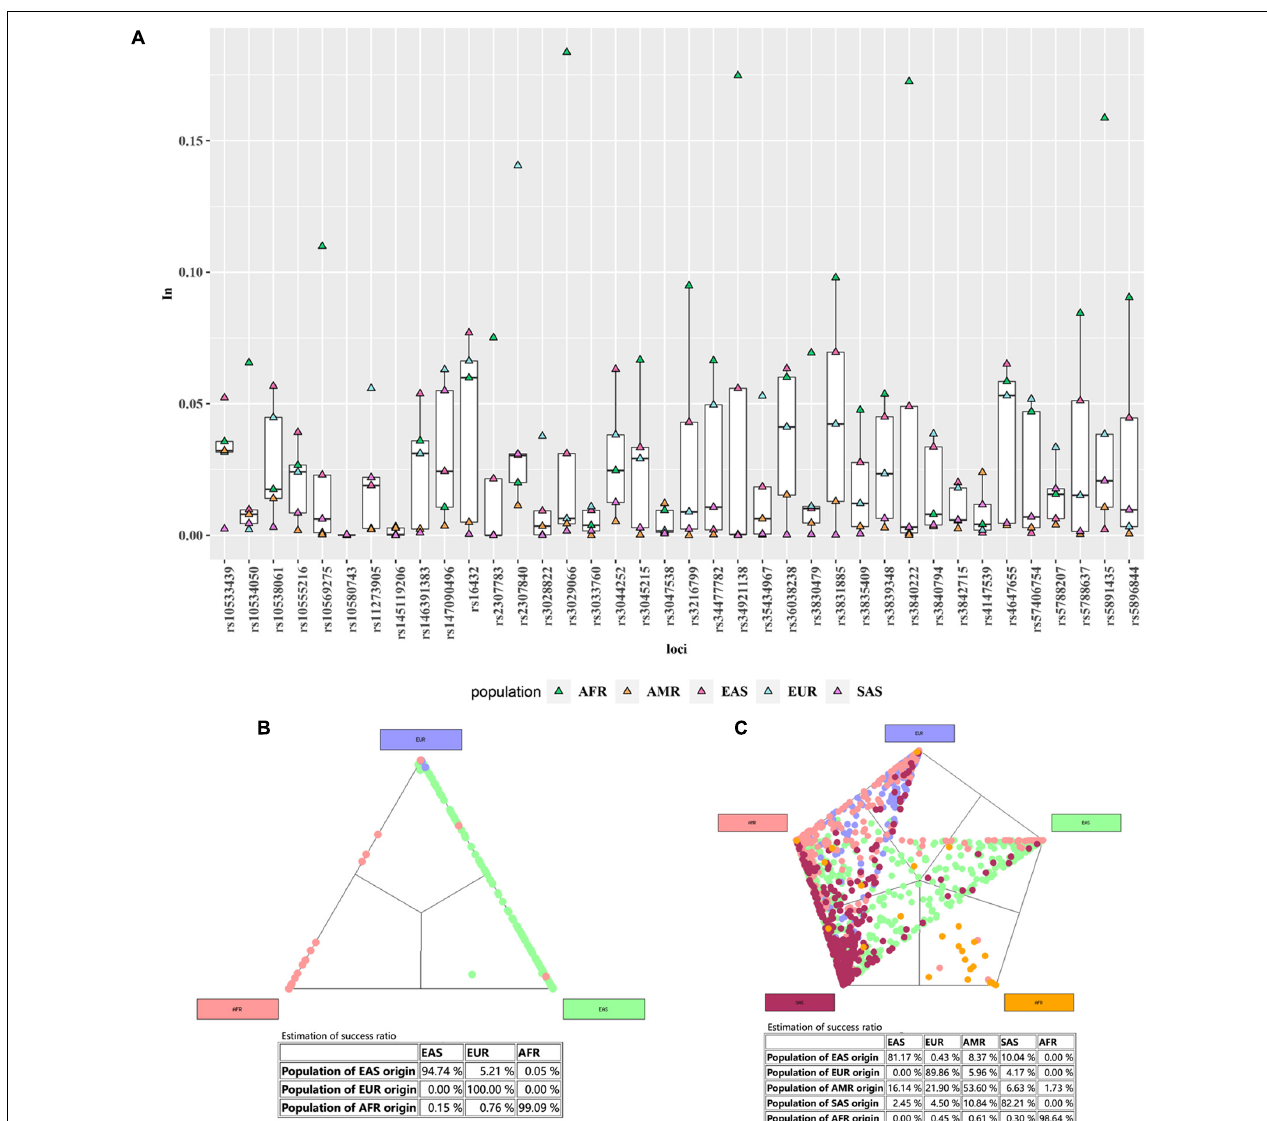
FIGURE 8 | The I n values of 38 AIDIPs in five intercontinental populations (A) ; the cross-validation success ratios of three continental populations (B) ; the cross-validation success ratios of five continental populations (C)